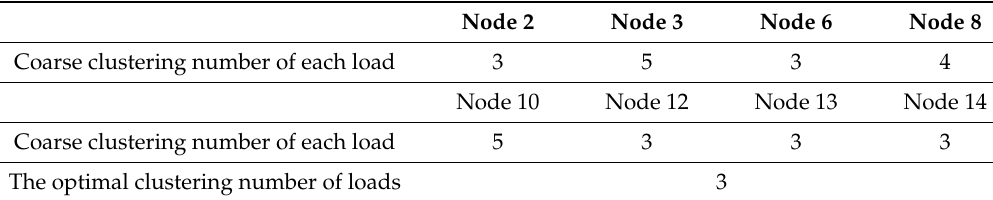
Table 3. Coarse Clustering Number of